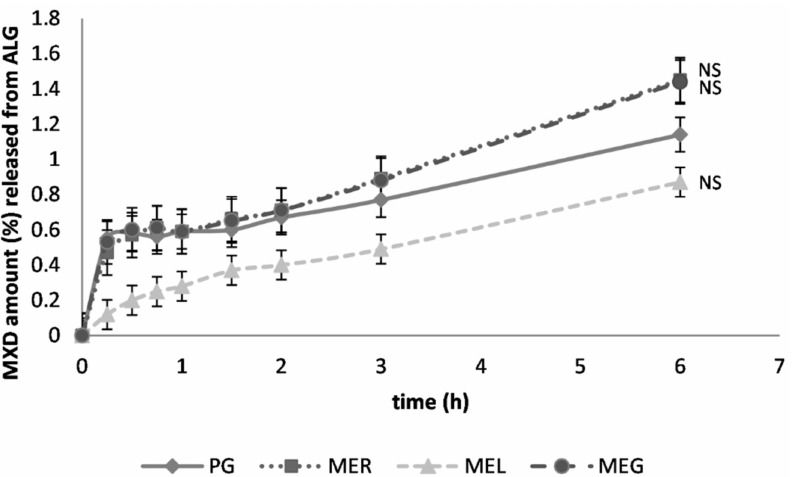
Figure 4. Ex vivo permeation of MXD from sodium alginate gel (ALG) through porcine ear skin; previous solubilization in propylene glycol (PG), reference ME R , lecithin-containing ME L or gelatin- containing ME G . The cumulative MXD amount (%), a mean ± SEM, n = 4. Non-significantly different data (NS) against reference are at p > 0.05. Table 4. Steady-State Flux (J SS ), Permeability Coefficients (C P ) and Enhancement Ratio (ER) for In Vitro and Ex Vivo Drug Release from the